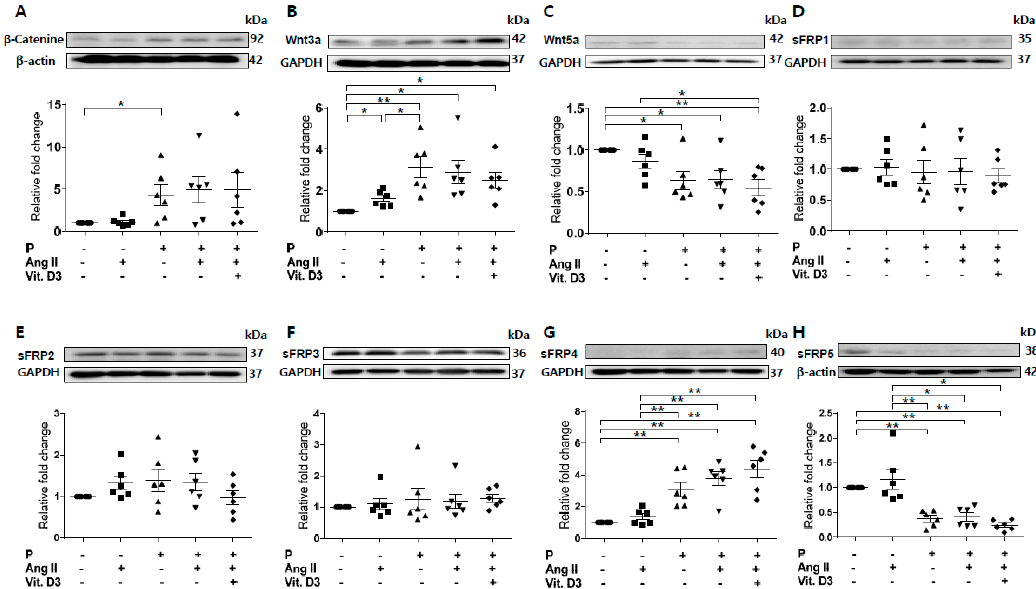
Figure 2. Expression of secreted frizzled-related proteins (sFRPs) and Wnt signaling in vascular smooth muscle cells (VSMCs) exposed to vascular calcification (VC) induction medium (high-phosphate, angiotensin II, and vitamin (D) were measured by Western blotting. Six replicates per condition were performed. The expression levels of β -catenin ( A ) and Wnt3a ( B ) were significantly increased and Wnt5a ( C ) expression was decreased in VC induction medium compared with the control. The expression levels of sFRP1 − 3 ( D – F ) were not a ff ected by the chronic kidney disease environment. The expression of sFRP4 ( G ) was increased and that of sFRP5 ( H ) was decreased in VC induction medium compared with the control. Data are expressed as means ± standard errors of the mean from six independent experiments. * p < 0.05, ** p < 0.01.